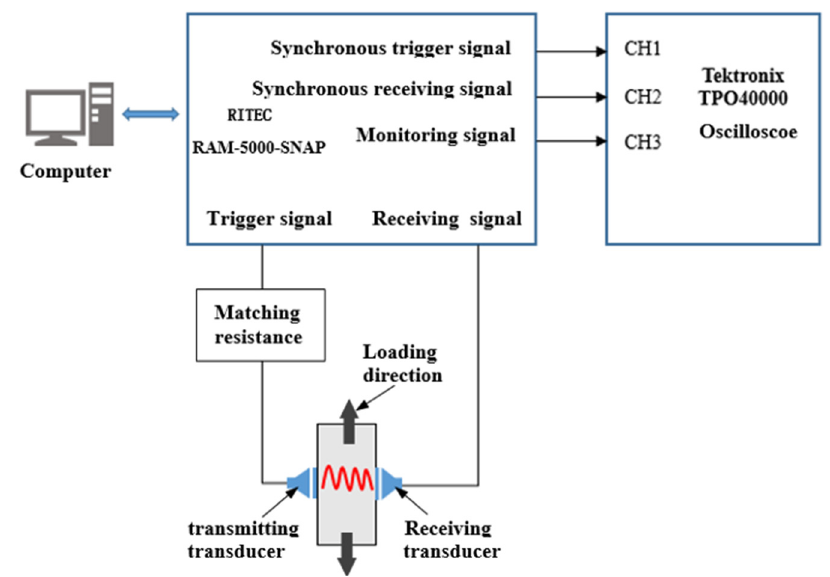
Figure 3. Schematic diagram of the nonlinear ultrasonic experimental system.